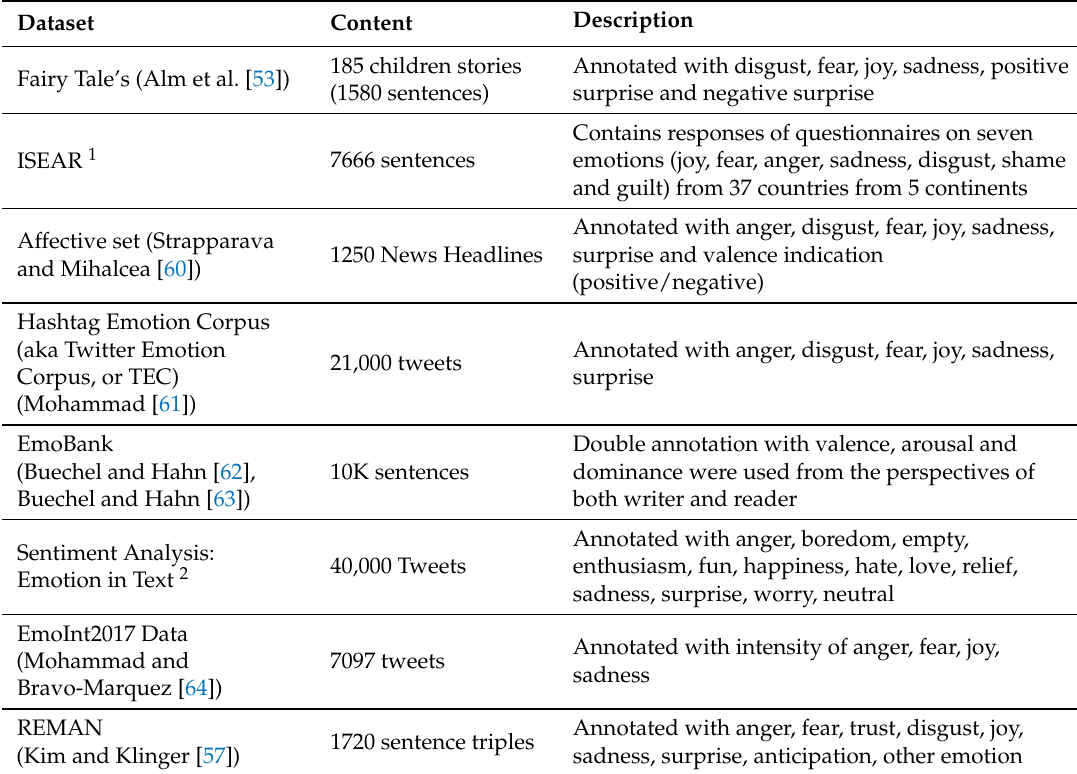
Table 2. Overview of datasets used in emotion detection.